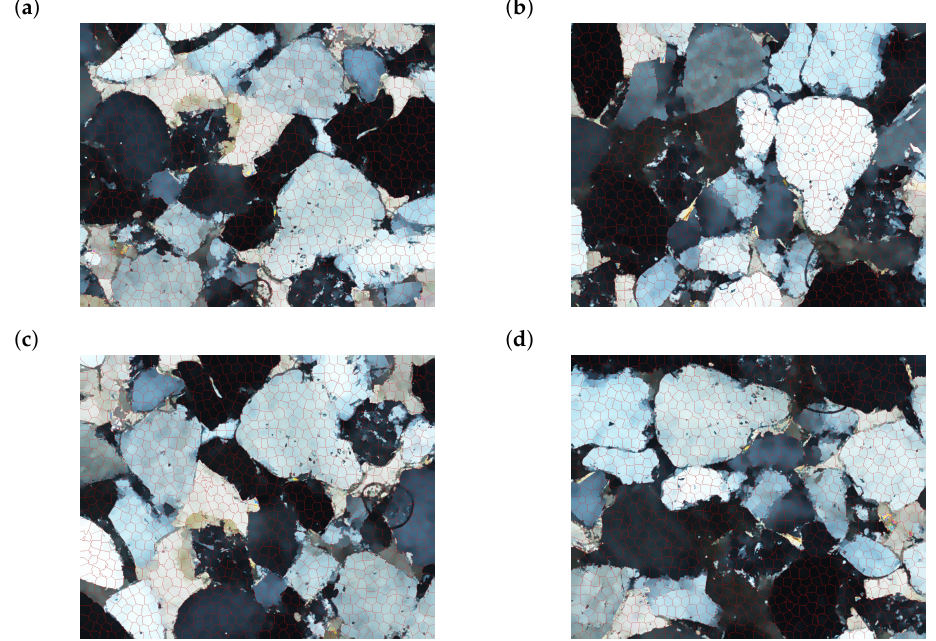
Figure 6. Images segmented by SLIC algorithm: ( a ) Angle 0°, ( b ) Angle 40°, ( c ) Angle 90°,